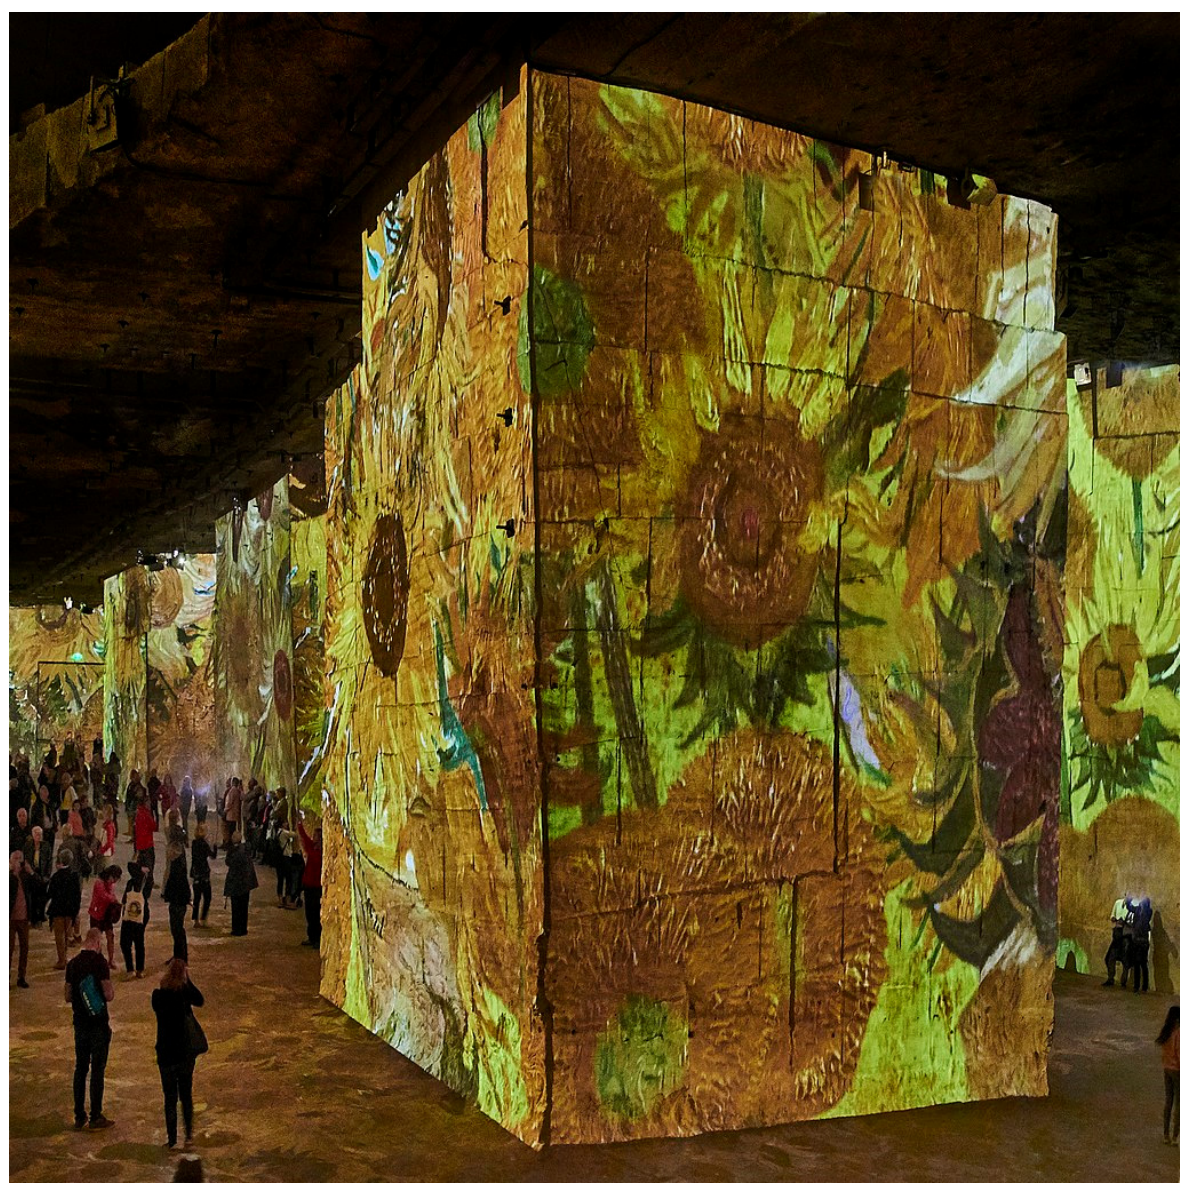
Figure 1. Vincent Van Gogh, la nuit étoilée is considered to be an inspiration for many of the Van Gogh immersive exhibitions to follow. Photo by marc carpentier is licensed under a Creative Commons Attribution 2.0 Generic License, via Wikimedia.